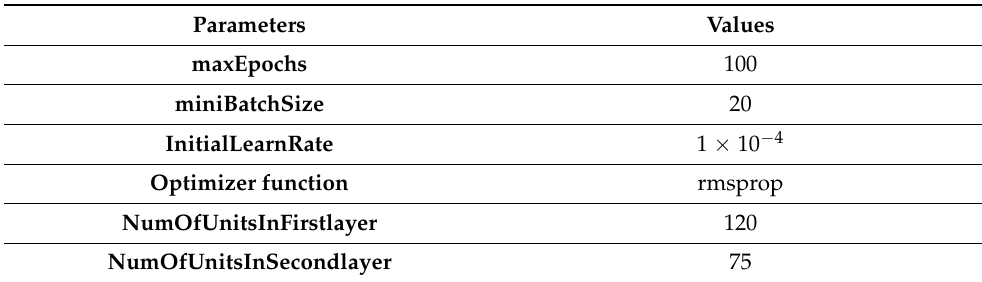
Table 2. The main parameter values of GRU